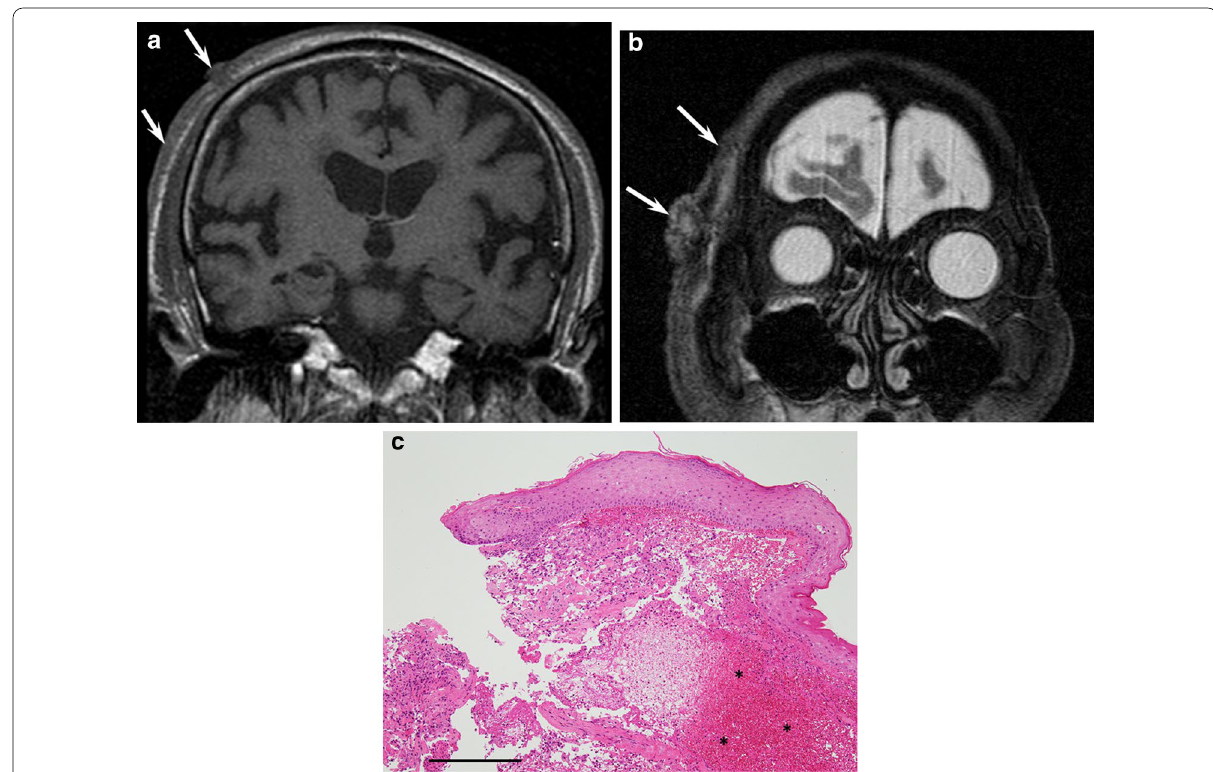
Fig. 11 A 91‑year‑old male with angiosarcoma on the scalp. a Coronal T1‑weighted image showing a horizontally spreading lesion (arrow) with a nodule (arrowhead). b Coronal fat‑suppressed T2‑weighted image showing elevated lesions with an obtuse angle with mixed hyper‑ and hypointensity (arrows). c Histological specimen (H&E stain; scale bar, 1 mm) showing atypical endothelial cells with massive hemorrhage in the